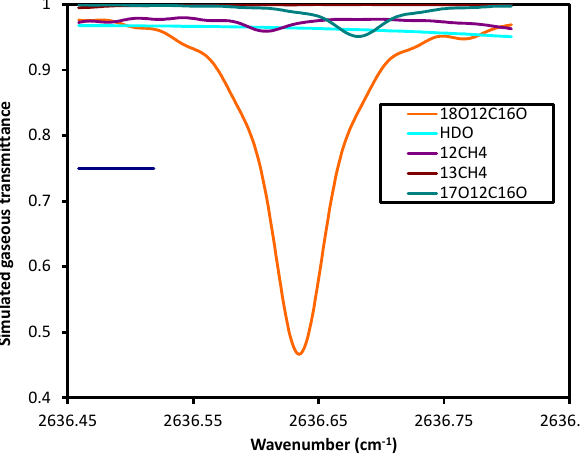
Figure 4. Transmittance contributions from various gaseous ab- sorbers in the 2637cm − 1 microwindow at TH = 6.3km. Other gases may provide trivial contributions. The portion of the mi- crowindow used to determine aerosol transmittance is shown in dark blue. The corresponding transmittance value of 0.75 is meaningless (only the wavenumber range is